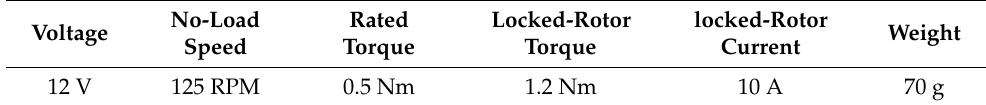
Table 2. Performance parameter table of DS_BN22.